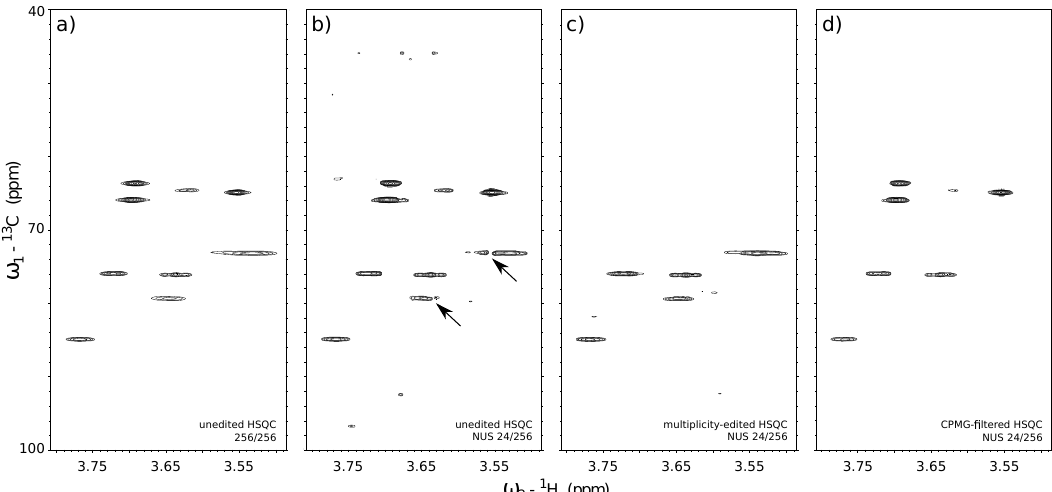
Figure 6. A reference unedited 13 C HSQC spectrum with conventional sampling of 256 t 1 ( 13 C dimension) × 3348 t 2 ( 1 H dimension) points matrix ( a ) and the reconstructed spectra obtained using only 24 t 1 sub-samples from corresponding experiments: unedited 13 C HSQC ( b ), 13 C HSQC with CH-only editing ( c ), 13 C HSQC with CPMG filter ( d ). The missing data for ( b – d ) was reconstructed with IRLS algorithm based on CS using 40 iterations. The virtual-echo method was applied in all the reconstructions. The processing was performed using mddnmr software [89]. The concentration of each compound in a sample was adjusted to yield similar peak heights in the 1 H NMR spectrum (ca. 0.6 mg/mL of sucrose, and 14.6 mg/mL of